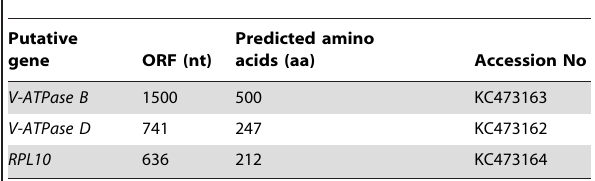
Table 2. Features of full-length cDNAs of V-ATPase B , V- ATPase D and RPL10 from Peregrinus maidis and their predicted translated